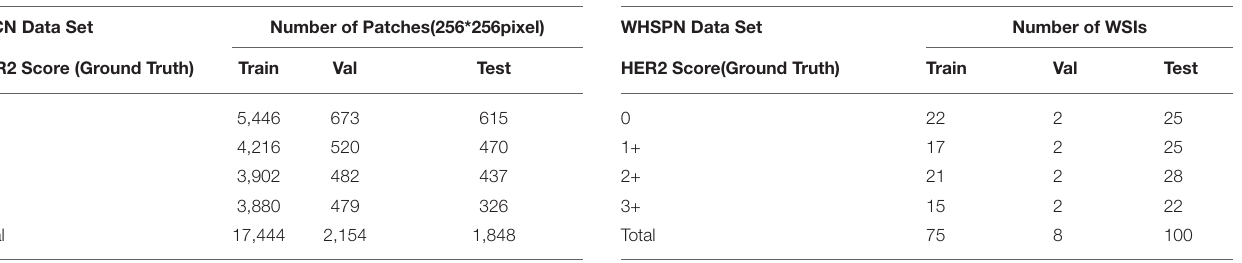
TABLE 3 | Demographics of the dataset used for WSI-level HER2 score prediction network